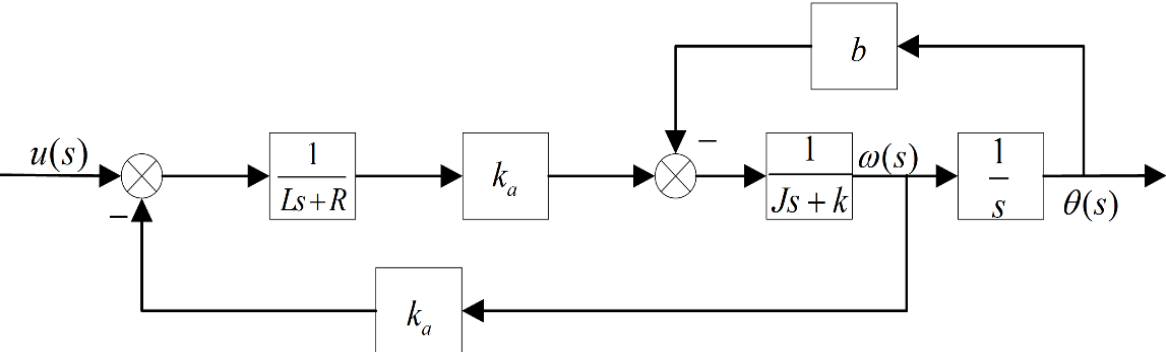
Figure 2. A mathematical model block diagram of the RT VCM.